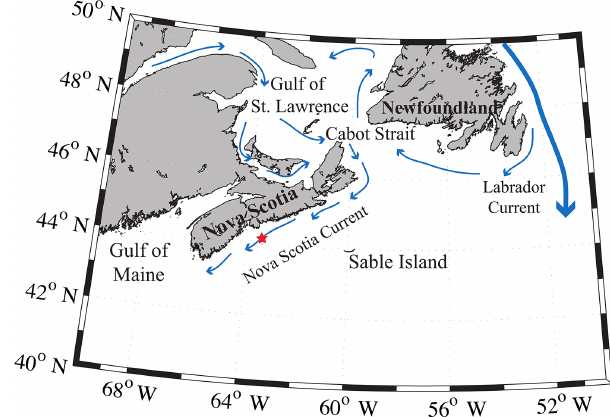
Figure 1. Regional view of the Scotian Shelf with primary currents shown. The red star depicts the location of the SeaHorse and CAR- IOCA moorings. Reprinted with minor modifications with permis- sion from Shadwick et al. (2010). ©Shadwick et al. (2010).